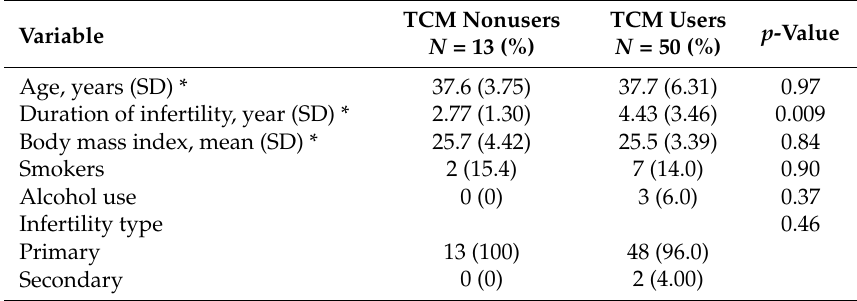
Table 1. Baseline characteristic between Traditional Chinese Medicine (TCM) users and nonusers.